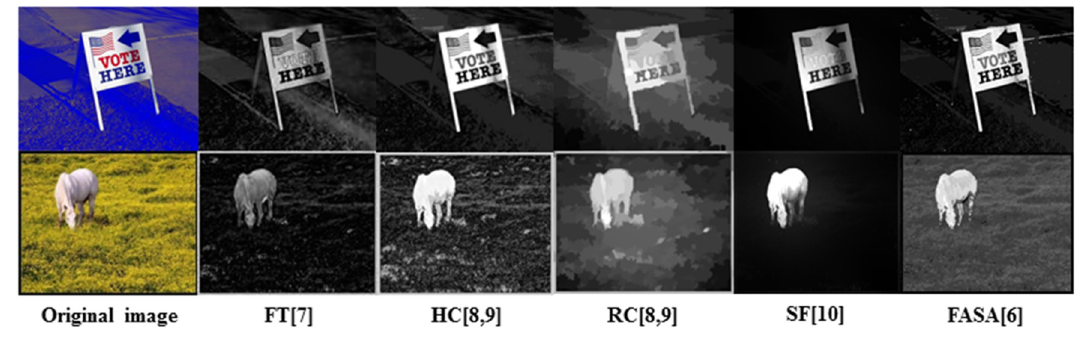
Figure 2. Examples of saliency maps generated by FT, HC, RC, SF and FASA